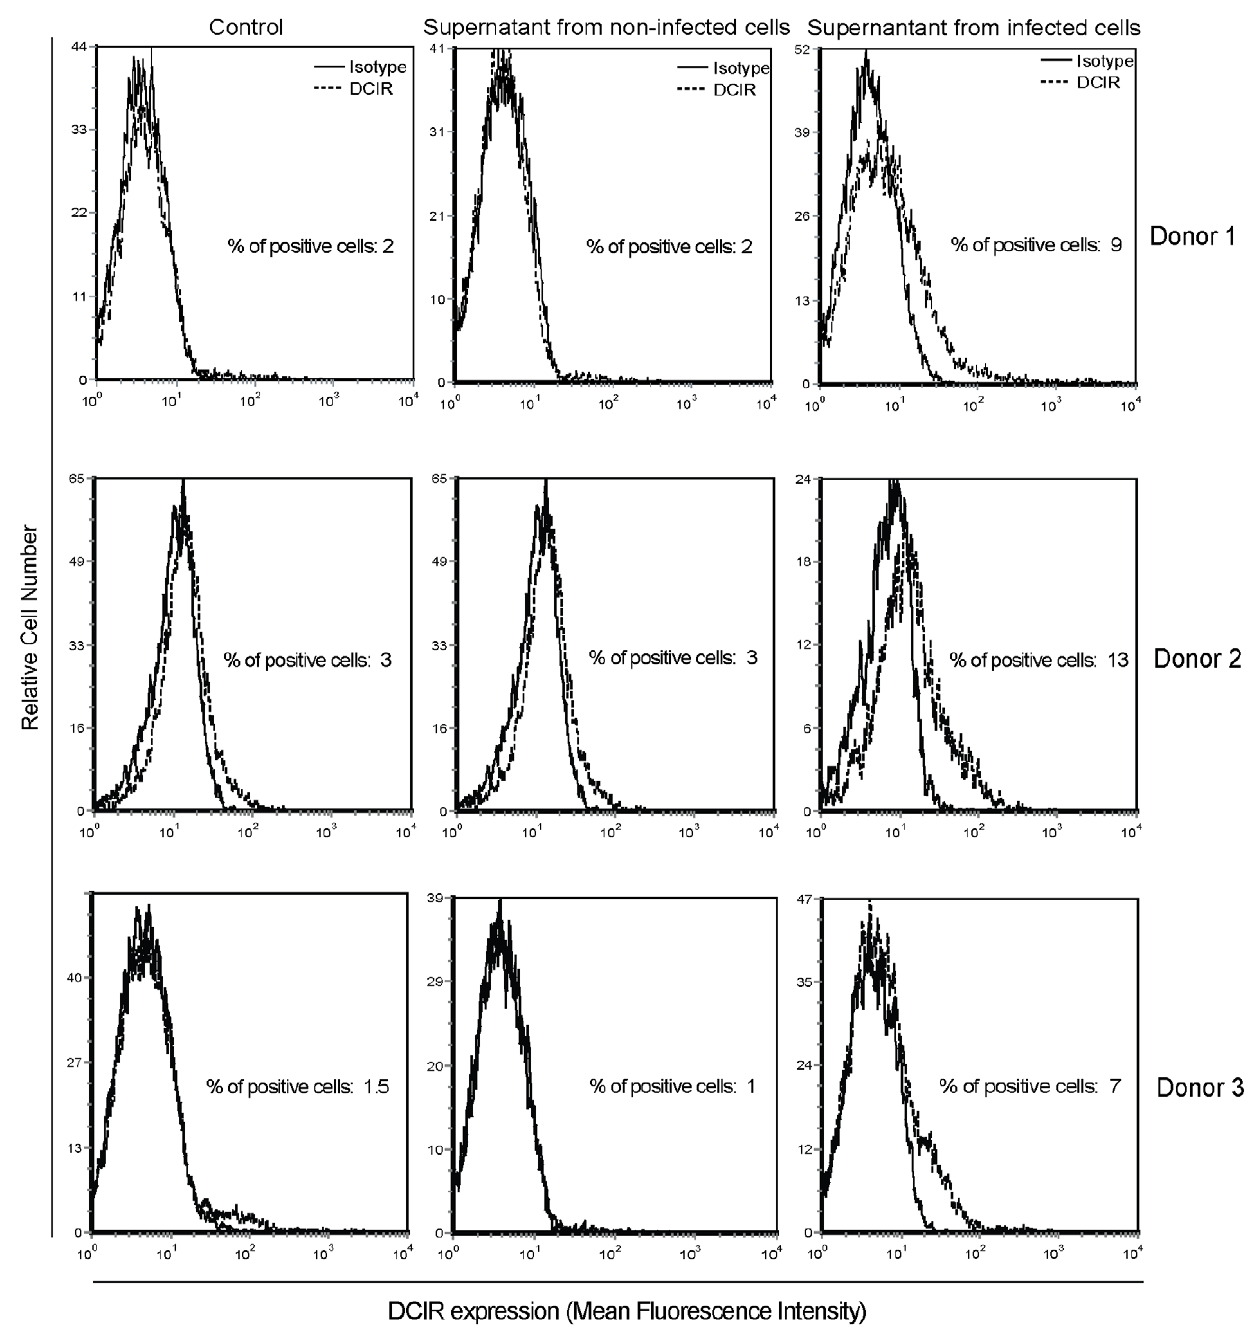
Figure 3. Soluble factors secreted by virus-infected cells promote DCIR expression. Cell-free supernatants from mock- and HIV-1-infected cells were used to treat purified CD4 + T cells. DCIR expression was monitored 3 days later by flow cytometry. Expression of DCIR is shown as a dotted line, whereas the continuous line represents staining obtained with an isotype-matched irrelevant control Ab. Data shown correspond to studies performed with three distinct donors.